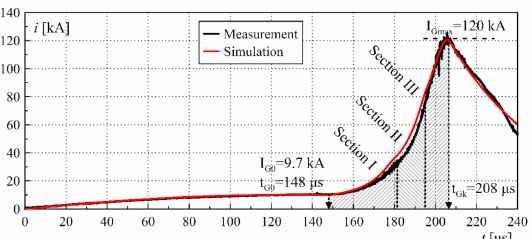
Figure 6. Summary of the simulation and experimental studies results of the FCG-based current generation process into a load with an inductance of 2.6 µ H with characteristic time intervals and values marked: t G 0 —start time of the generation process, I G 0 —initial value of the FCG current, t Gk —end time of the generation process, I Gmax —maximum generated value of the FCG